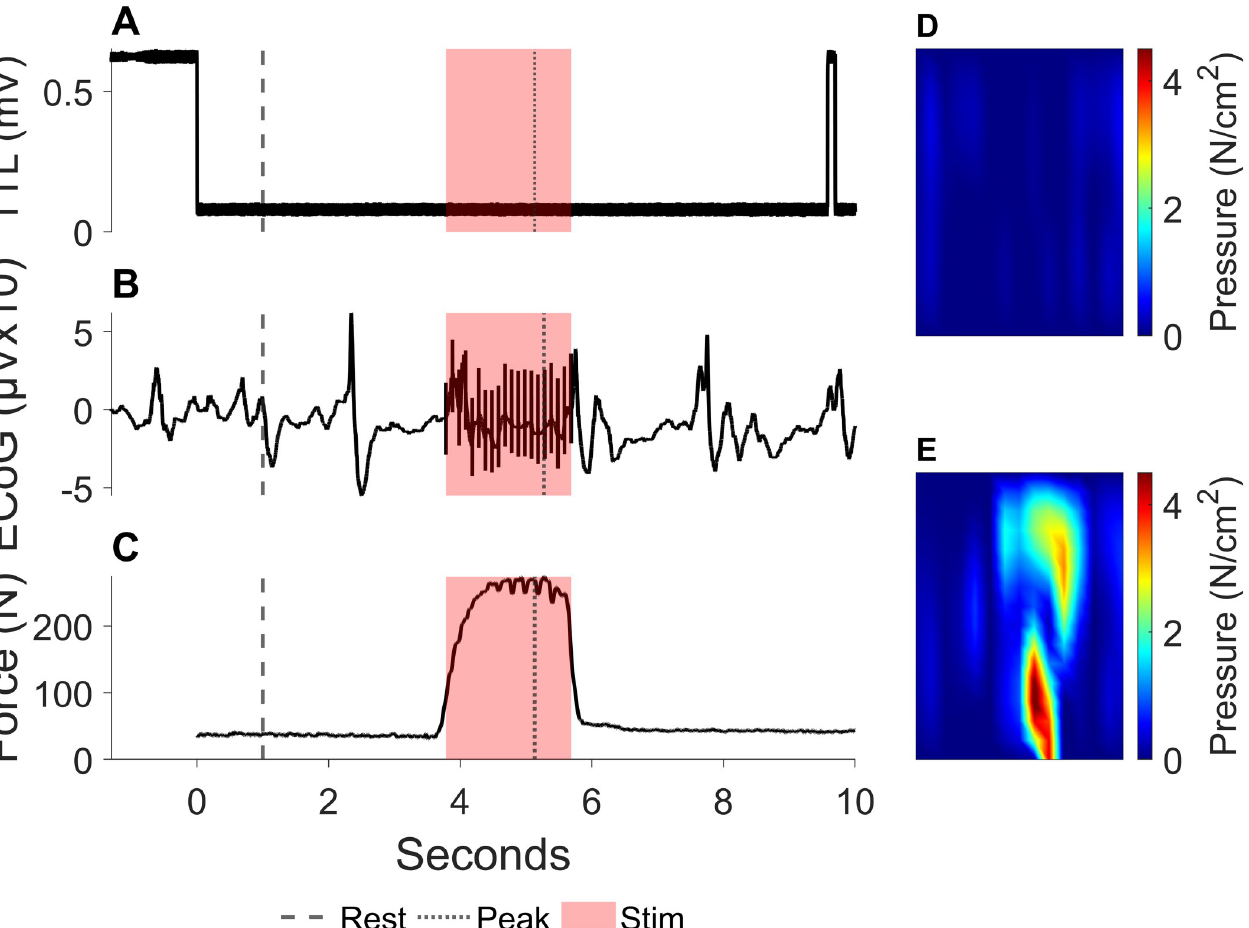
Fig 4. Sample kinetic whole hand trial. (A) TTL voltage signal from the button press that initiates and stops recordings. (B) ECoG from one electrode during a whole hand squeeze trial in the operating room with a rest frame and peak force frame marked. Stimulation period is marked with red box. (C) Force output from the F-Socket during a whole hand squeeze trial in the operating room with a rest frame and peak force frame marked. Stimulation period is marked with red box. (D) F-socket pressure map (15 x 16 sensors/544.8 x 190.5mm) during the rest frame. The top and bottom of the frame shows pressure from the fingers and thumb., respectively. (E) F-socket pressure map during the peak force output